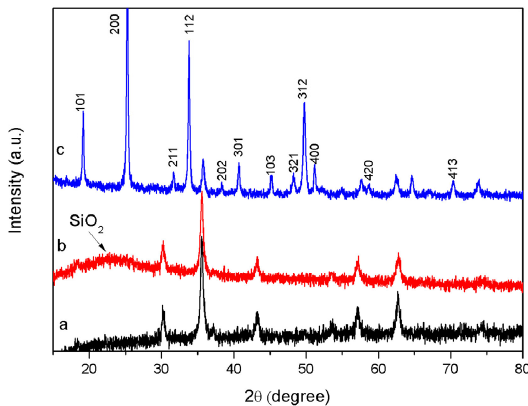
Figure 1. X ‐ ray diffraction (XRD) patterns of pure Fe 3 O 4 ( a ), Fe 3 O 4 @SiO 2 ( b ) and Figure 1. X-ray diffraction (XRD) patterns of pure Fe 3 O 4 ( a ); Fe 3 O 4 @SiO 2 ( b ) and Fe 3 O 4 @SiO 2 @GdVO 4 Fe 3 O 4 @SiO 2 @GdVO 4 :Dy 3+ ( c ). The diffraction peaks that are indexed in 1c correspond to GdVO 4 .